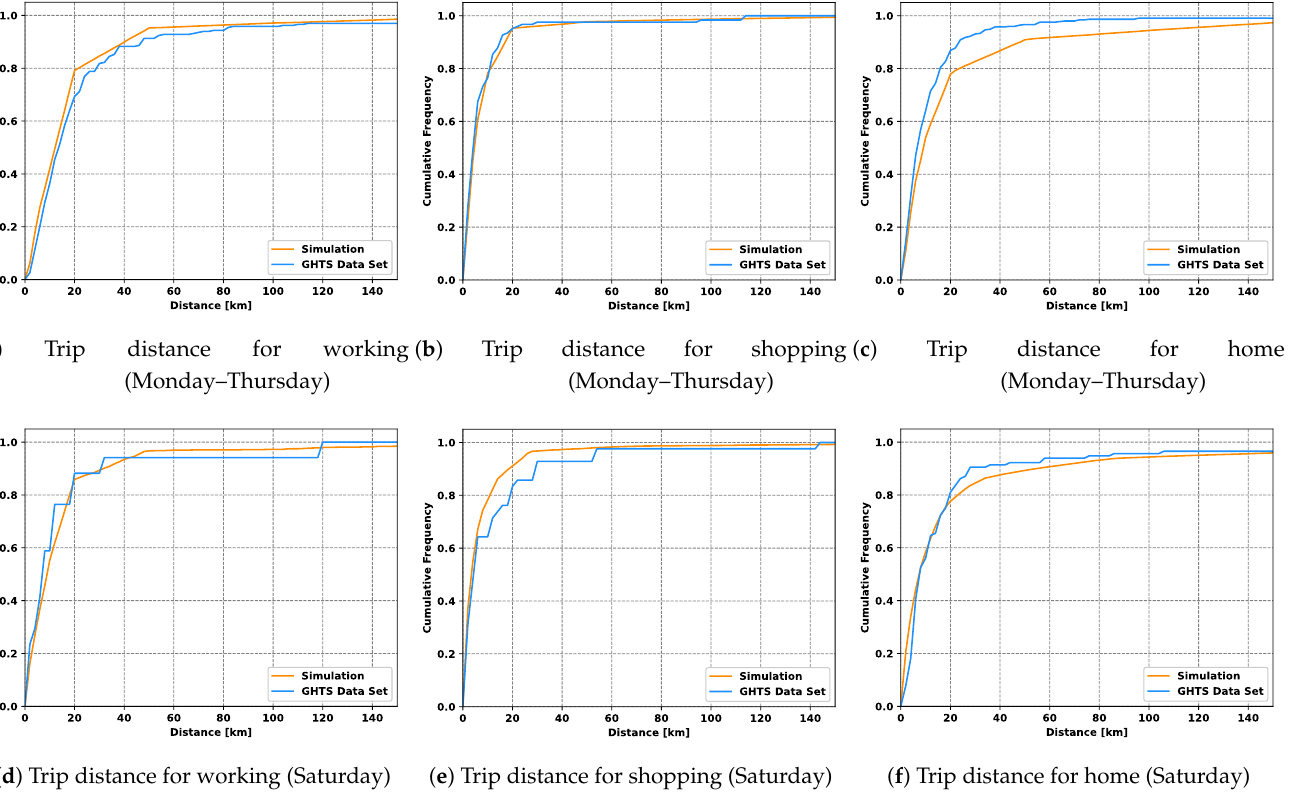
Figure 7. Cumulative distribution function for trip distance—simulation and German household travel survey (GHTS) data set